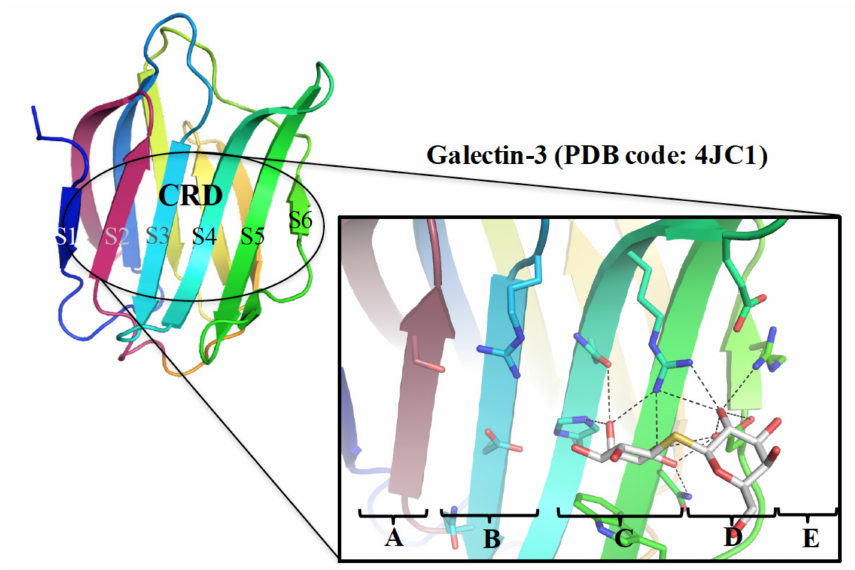
Figure 1. Galectin CRD contains five subsites (A–E; GAL-3 is shown here for instance) where thiodigalactosides bind, interacting with subsites C and D in a similar manner to lactose or N